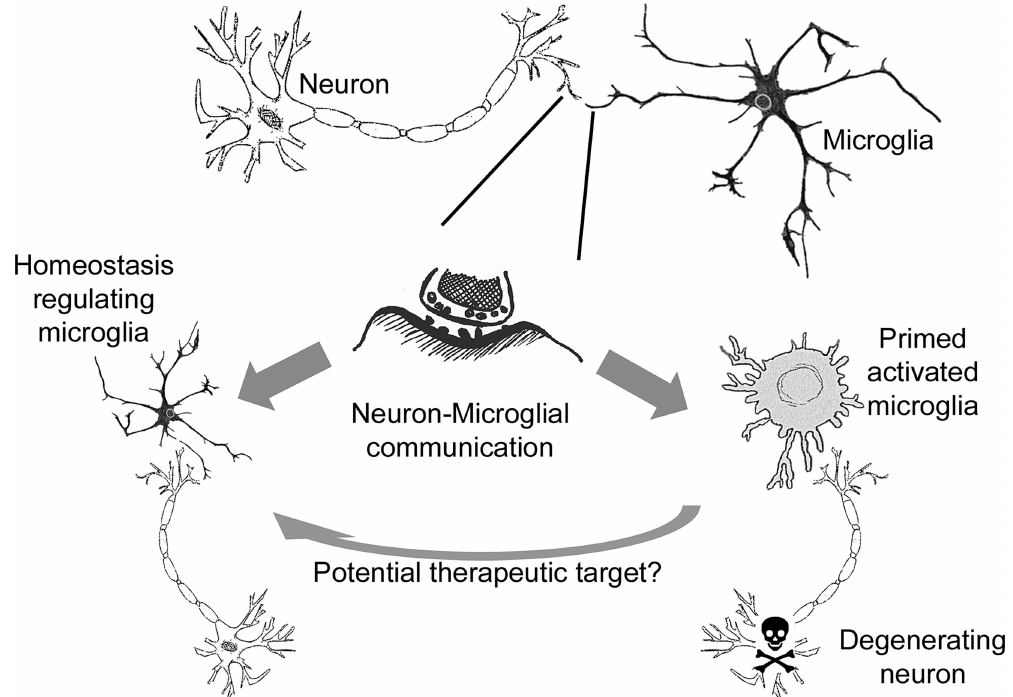
Fig 8. Microglial-neuron communication may define the relative resilience or susceptibility of neurons to degenerate. Microgliaare known to survey the neuronalparenchyma and interact intermittently with all parts of the neuron. The accumulation of misfoldedPrP, and potentiallythe different types of aggregates, will have an impact on the communication and interaction betweenneuronsand microglia. As a result, we observedifferent microglial responses duringdiseaseas well as selective vulnerability of neuronsto degeneratein specific brain regions. It remainsunclear whetherthe physiological differences of neuronalsignalling,the known gene expression differences of microgliabetweenbrain regions[37], or the different types of misfoldedPrP aggregate are responsible for the different microglial activationstates. Based on the associationsbetweenthe different microglial activationstates, the restricted neurodegeneration observed, and current knowledgeof the importance of innate immune activationin definingseverity of neurodegeneration,we speculatethat the different microglial activation states could be definingneurodegeneration betweendifferent brain regions. This could either occur as a protective microglial response in regions showingresilience to neurodegeneration or a contributor to neurodegeneration in susceptibleregions, or both. Our study highlights the need to further understand the basis for different microglial activationstates, which could allow future studies to manipulate microglial responsesfrom a primedactivated state to one that regulateshomeostasis and, thus, could representa vital therapeutictarget for interventionduring